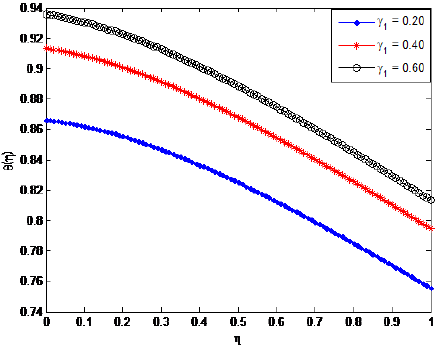
Figure 4. Influence of the first thermal Biot number on dimensionless temperature profile